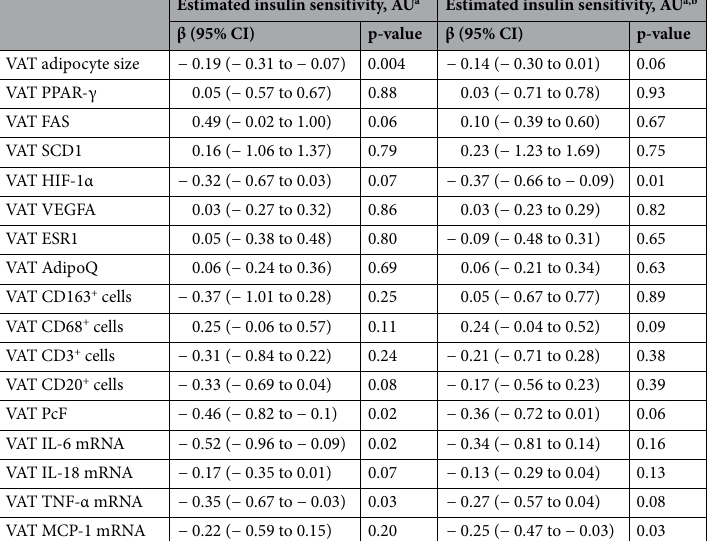
Estimated insulin sensitivity, AU